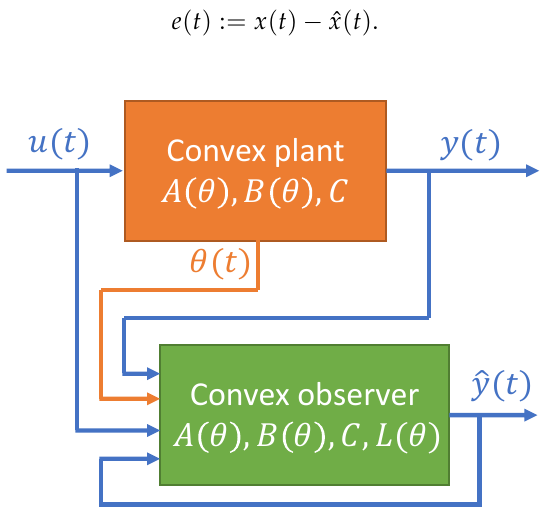
Figure 5. Convex state observer